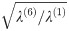
The sixth eigenvector components.We multiply the sixth eigenvector components by λ(6)/λ(1). We include the names for the nodes that have large absolute values for the entire period. In this eigenmode the largest contribution comes from the Iceland’s stock market, followed by the Icelandic krona. Closely following Iceland, are Polish and Russian stock markets with positive correlation and oil exporting countries’ stock markets with negative correlation.